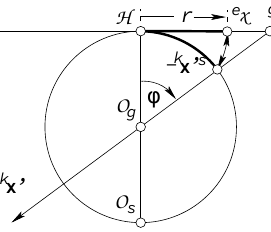
Figure 3: Relation between sensor point, viewing direction and viewing ray.